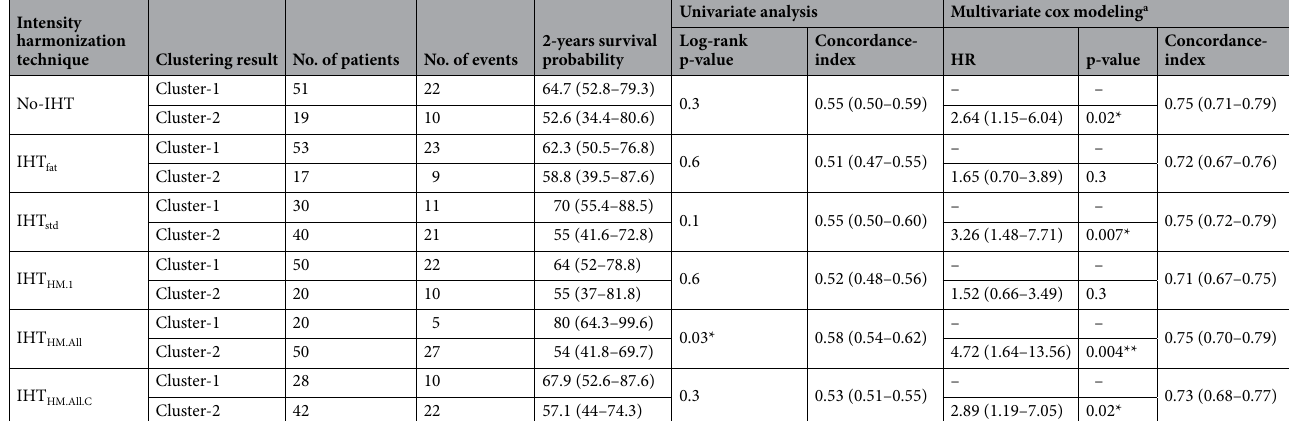
Table 4. Unsupervised analysis based on radiomics features (RFs)—Prognostic value of the clustering results depending on the intensity harmonization technique (IHT). Results for 2-years survival probability, hazard ratio and concordance-index are given with 95% confidence interval. a Multivariate Cox modeling were adjusted for the following clinical and pathological covariables: performance status, histotype, initial longest diameter of the tumor, type of neoadjuvant chemotherapy, number of cycles of chemotherapy, surgical margins, histological response and adjuvant Radiotherapy. HM histogram matching, HR hazard ratio, No: number. *: p < 0.05, **: p < 0.005, ***: p < 0.001.